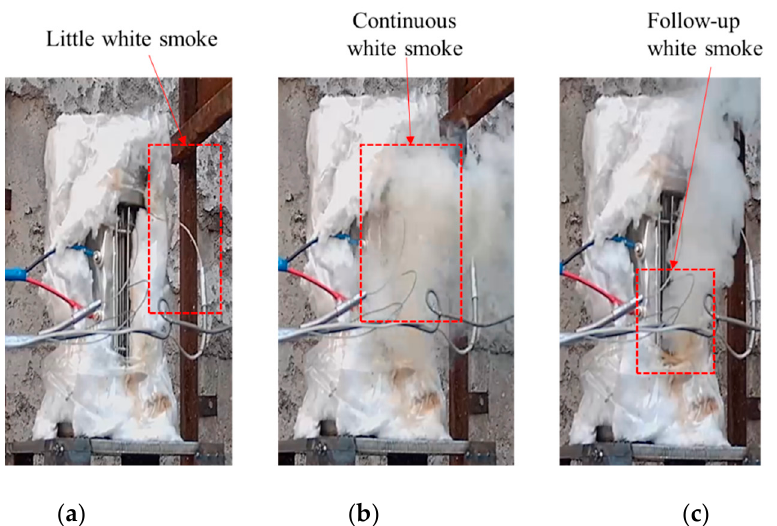
Figure 11. Response of cook-off bomb of shot 3. ( a ) Initial ignition. ( b ) Secondary jump. ( c ) Hysteretic jump.